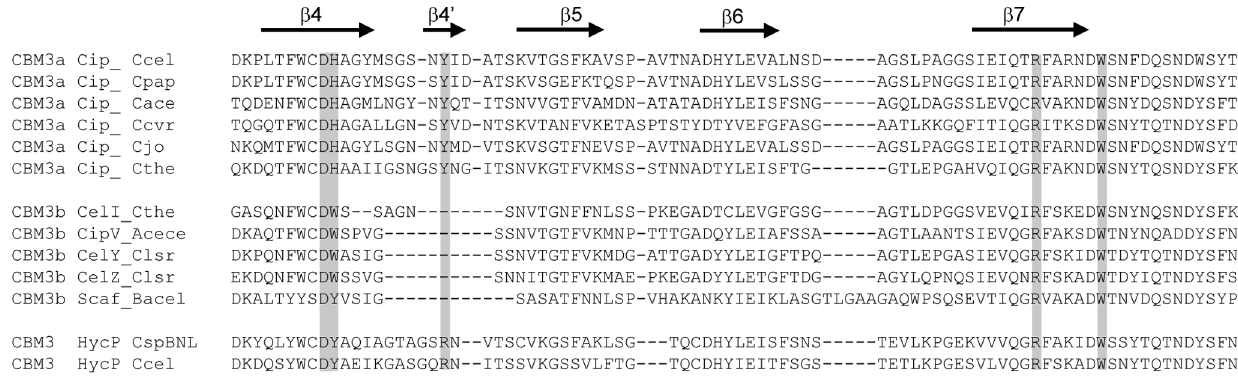
Figure 2. Amino-acid sequence alignment of CBM3a and CBM3b from various CBM3a or CBM3b containing proteins. Alignment has been performed using ClustalW2. It is focused on residues considered to participate in planar interaction with cellulose, highlighted in grey box. Regions of secondary structure are marked with an arrow and labeled as in the structure of the CBM3a of the scaffolding protein CipA from Clostridium thermocellum (Tormo 1996). CBM amino-acid sequence aligned (accession numbers codes in parentheses) are: Cip_Ccel(YP_002505087) and HycP_Ccel (YP_002505824) from Clostridium cellulolyticum ; HycP_CspBNL (YP_005147316) from Clostridium sp. BNL1100 ; Cip_Cpap (ZP_08194681) from Clostridium papyrosolvens ; Cip_Cace (NP_347546) from Clostridium acetobutylicum ; Cip_Ccvr (ZP_07630535) from Clostridium cellulovorans ; Cip_Cjo (BAA32429) from Clostridium josui ; Cip_Cthe (ZP_14248391) and CelI_Cthe (AAA20892) from Clostridium thermocellum ; CipV_Acece (AAF06064) from Acetovibrio cellulolyticus ; CelY (YP_007373484) and CelZ (CAA39010) from Clostridium stercorarium ; Scaf_Bacel (AAG01230) from Bacteroides cellulosolvens .